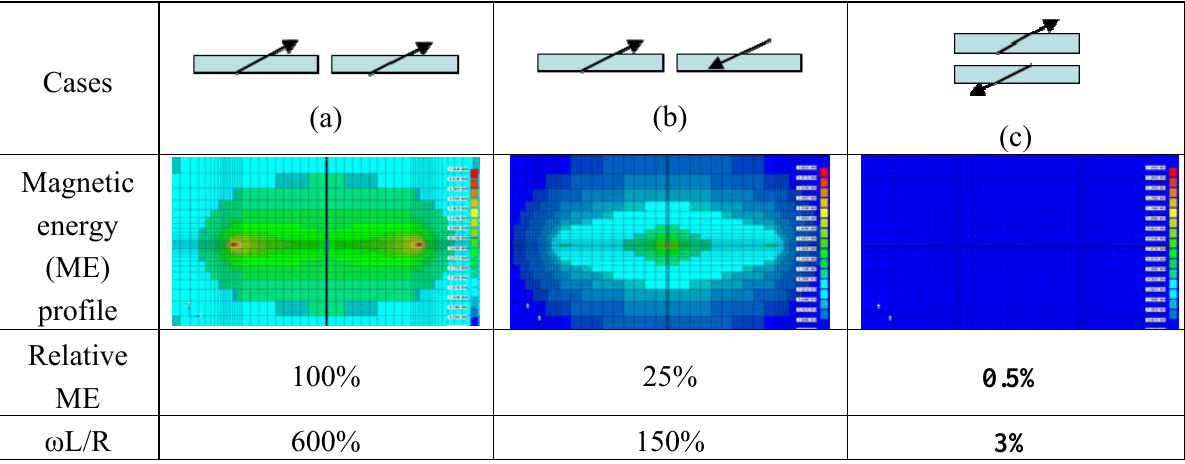
Table 3. Implementations for on-chip inductance reduction. Wire thickness, width and length are 0.8; 400 and 10,000 μ m respectively.